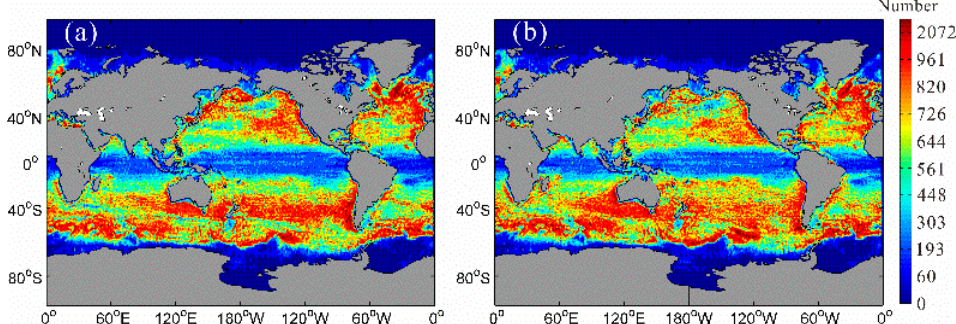
Figure 1. Geographical distribution of the identified ( a ) anticyclonic and ( b ) cyclonic eddy signals in each 1° × 1° region over a period of 23 years from 1993 to 2015.